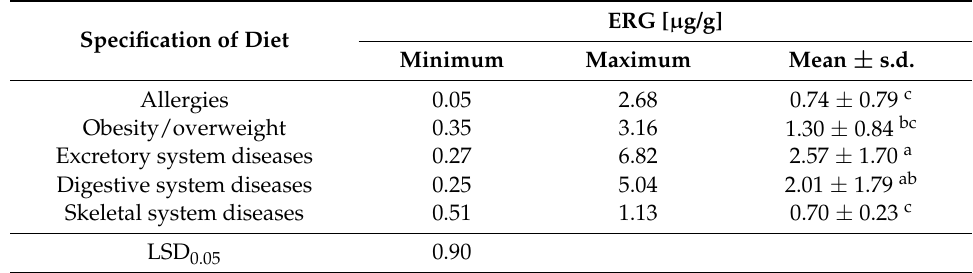
Table 3. Minimum, maximum, and average values of ergosterol in veterinary diets. Diets were grouped based on the diseases, consecutive upper superscript letters mark groups which differ significantly.